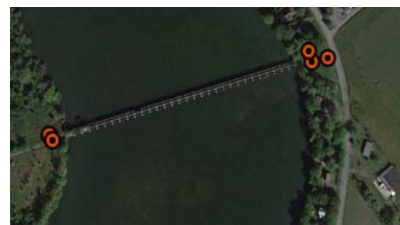
Figure 4: GCP distribution for Fryer Dam viewed in Google Maps